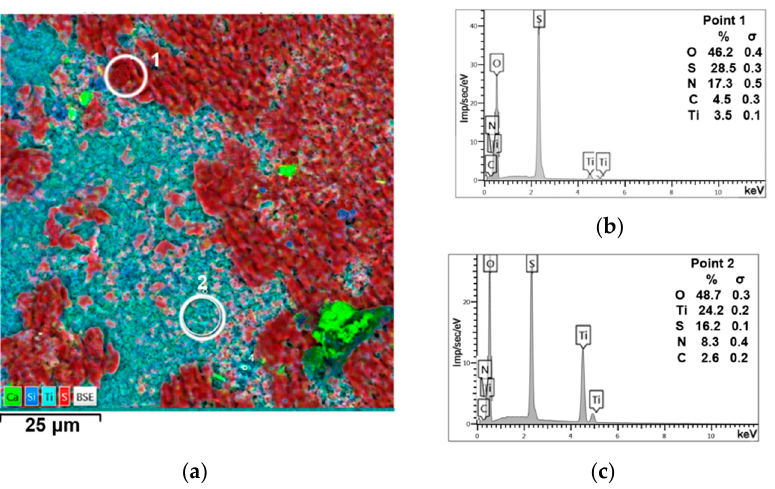
Figure 5. Structure mapping ( a ) and energy dispersive spectrum at different points (points ( b )—1, ( c )—2) of the modified fraction of titanium hydride under dynamic conditions in the presence of NH 4 OH (pH = 4–5).